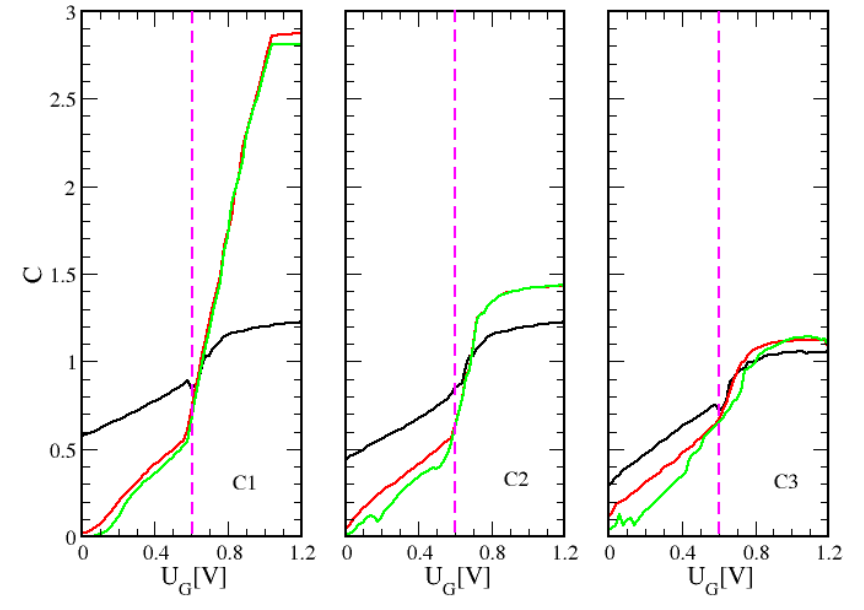
Figure 5. The calibration function C ( U G ) for the environment temperature T = 398 K (black), T = 298 K (red, room temperature) and T = 233 (green) for C1 ( left ), C2 ( middle ) and C3 (right ). The threshold ∼ 0.6 V is marked with a vertical line in voltage U th G